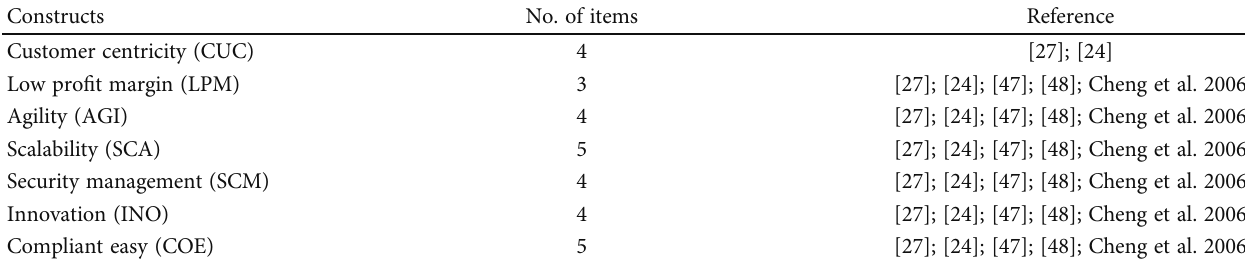
Table 2: Construct and